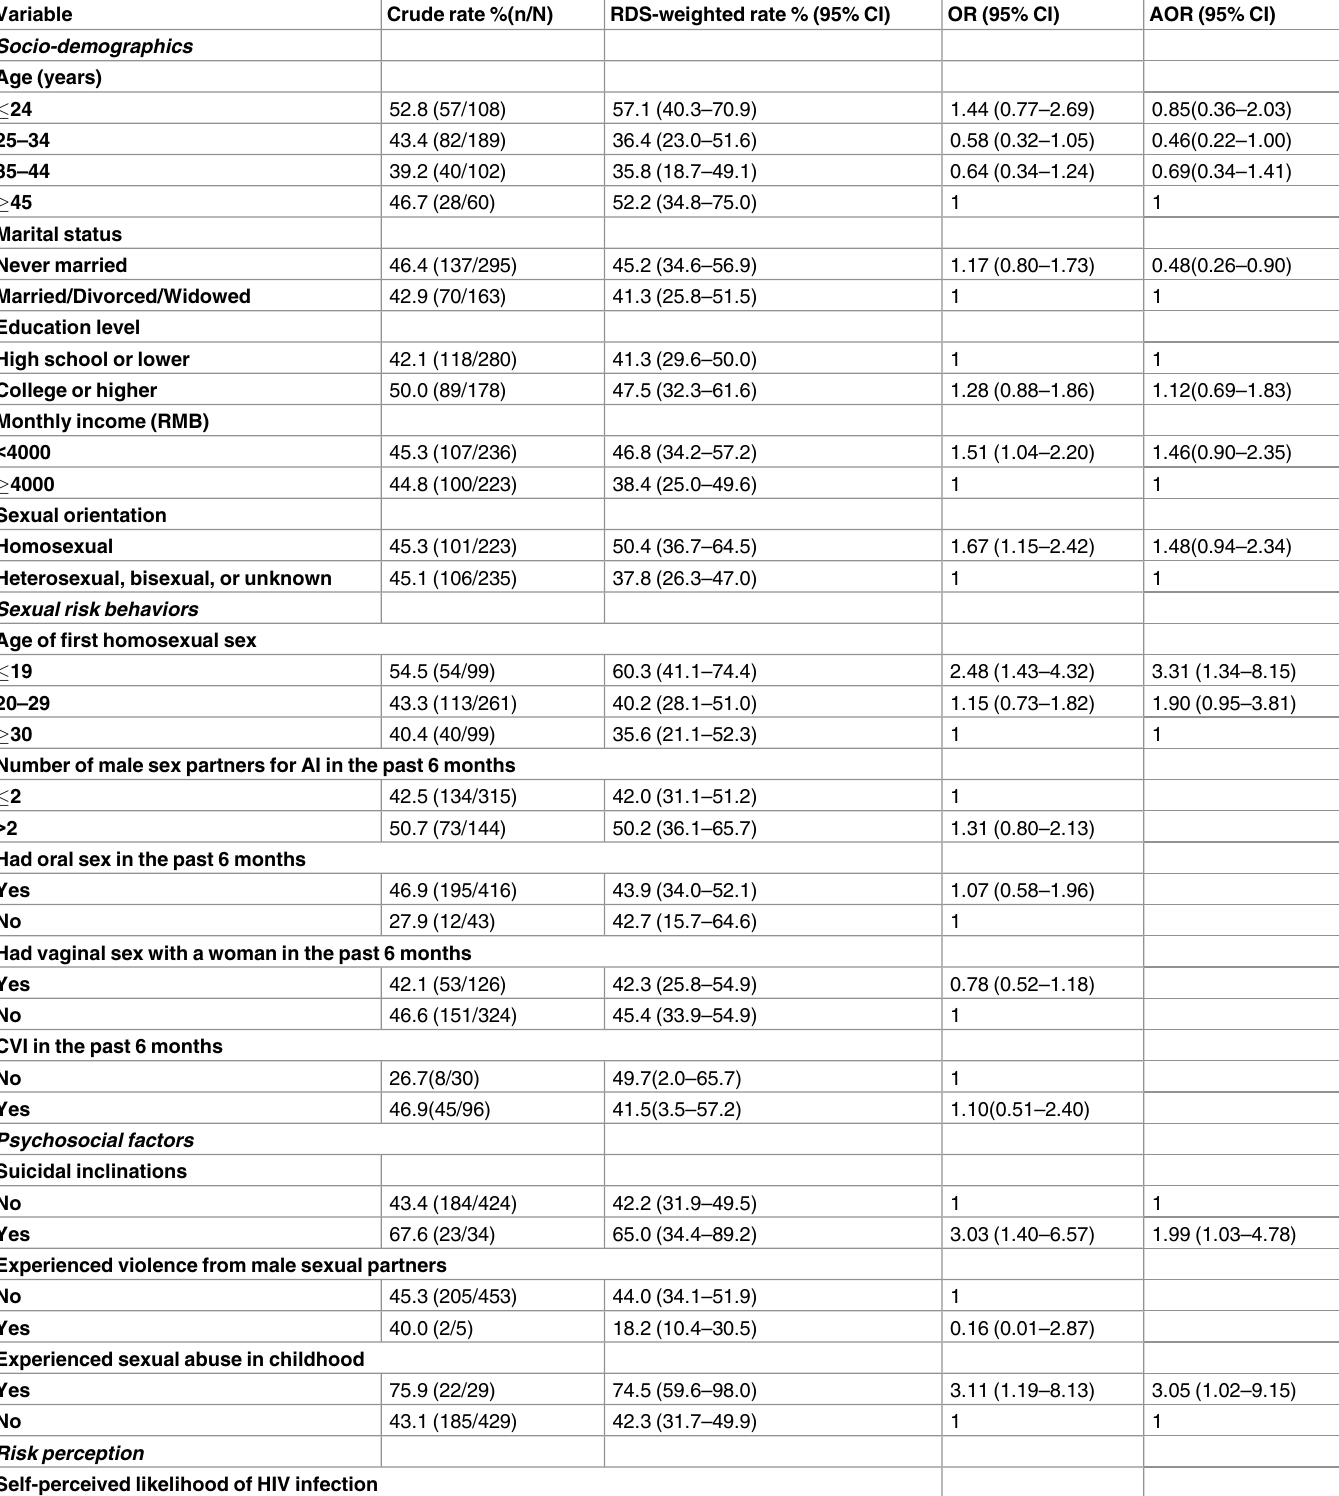
Table 2. Factors associated with CAI in the past 6 months (N =